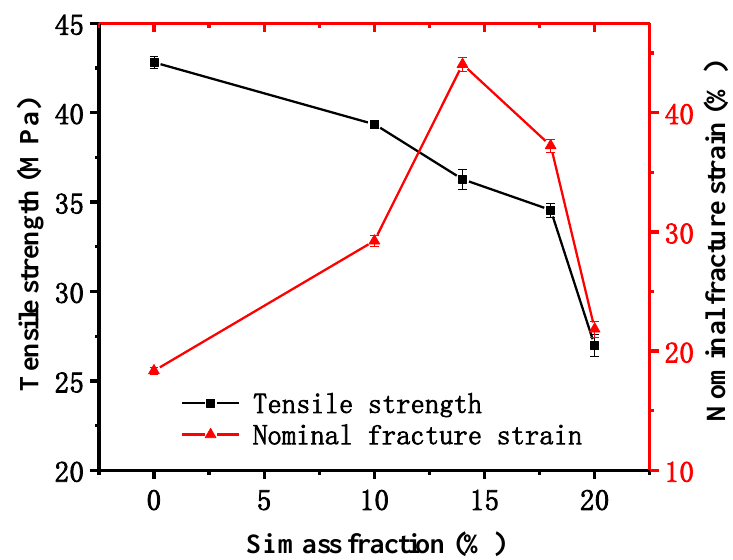
Figure 6. Mechanical properties of Bio-phenol polysiloxane/polycarbonate (Si/PC) copolymer with different Si mass fraction. Table 2. Oxygen transmission rate of the Si/PC copolymer with different Si mass fraction.